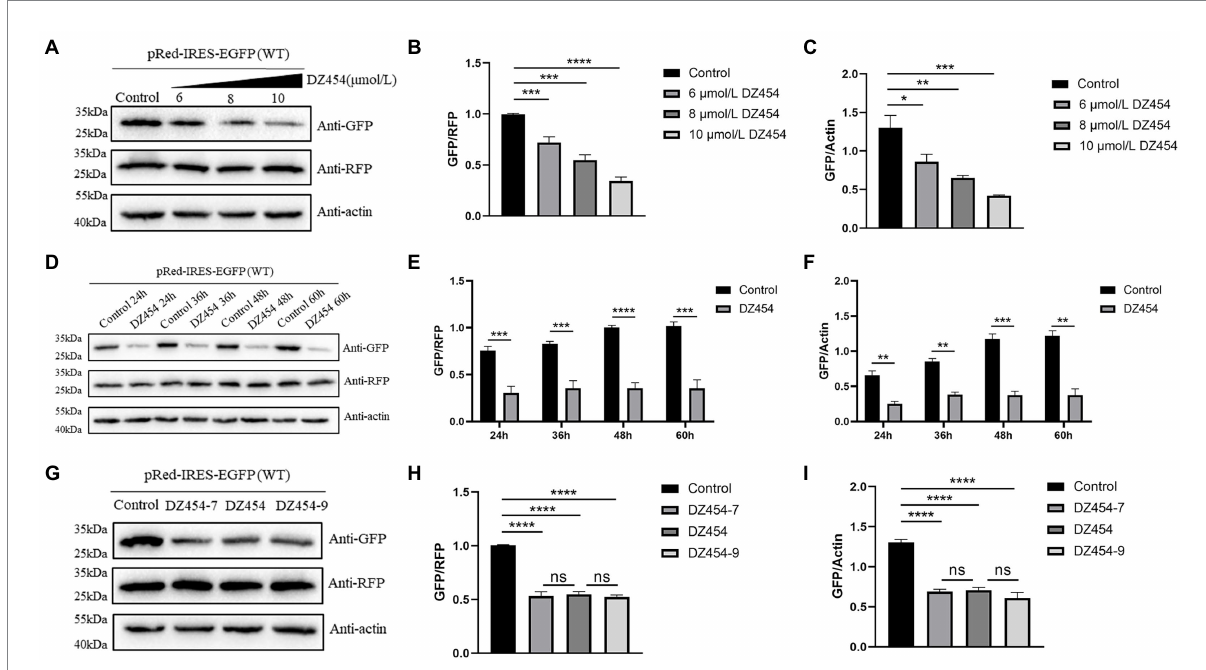
FIGURE 7 DZ454 inhibits the translation mediated by the 300–618 nt of DHAV-1 5 ′ UTR. (A) pRed-IRES-EGFP was cotransfected with 6, 8, and 10 μ mol/L DZ454 in DEFs, and 48 h later, the cells were collected and analyzed by immunoblotting with the indicated antibodies. (D) pRed-IRES-EGFP was cotransfected into DEFs with 10 μ mol/L DZ454, and the cells were harvested at different time points for immunoblot analysis with the indicated antibodies. (G) pRed-IRES-EGFP and DZ454 of different flank lengths (DZ454-7, DZ454, or DZ454-9) were cotransfected into DEFs. The cells were collected 48 h after transfection, and western blot analysis was performed with the indicated antibodies. (B,E,H) Band intensity was quantified using ImageJ software, and RFP was used as the mandatory control. The ratio of GFP to RFP was normalized to the control group. (C,F,I) Band intensity was quantified using ImageJ, and β -actin was used as the loading control. The ratio of GFP to β -actin was normalized to the level in the control group. Differences between two groups were calculated by Student’s t -test and significance is indicated by * p < 0.05; ** p < 0.01; *** p < 0.001; or **** p <